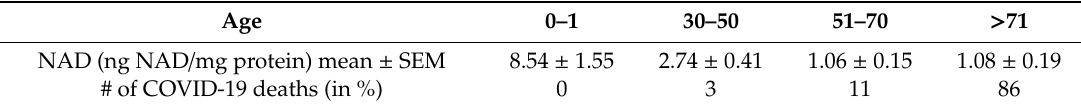
Table 5. Age dependence of NAD and deaths due to COVID-19.